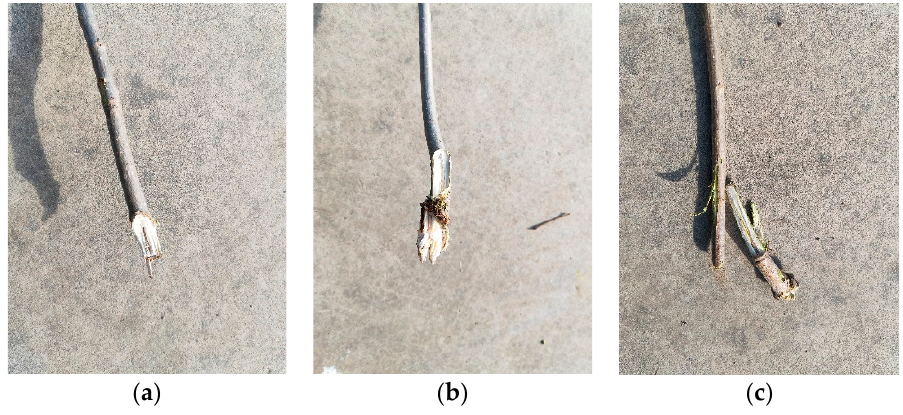
Figure 15. Forest test operations. ( a ) Late spring pruning; ( b ) winter pruning.